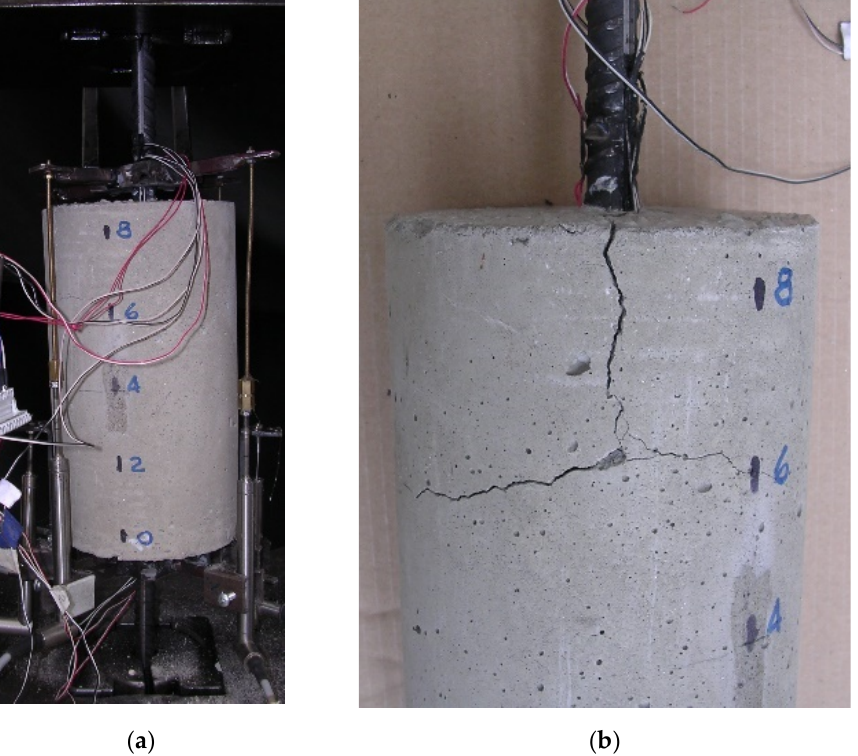
Figure 16. Reinforced concrete specimen n.3 tested at the Laboratory of the University of Pisa: ( a ) specimen before the test, ( b ) cracked specimen after the test.